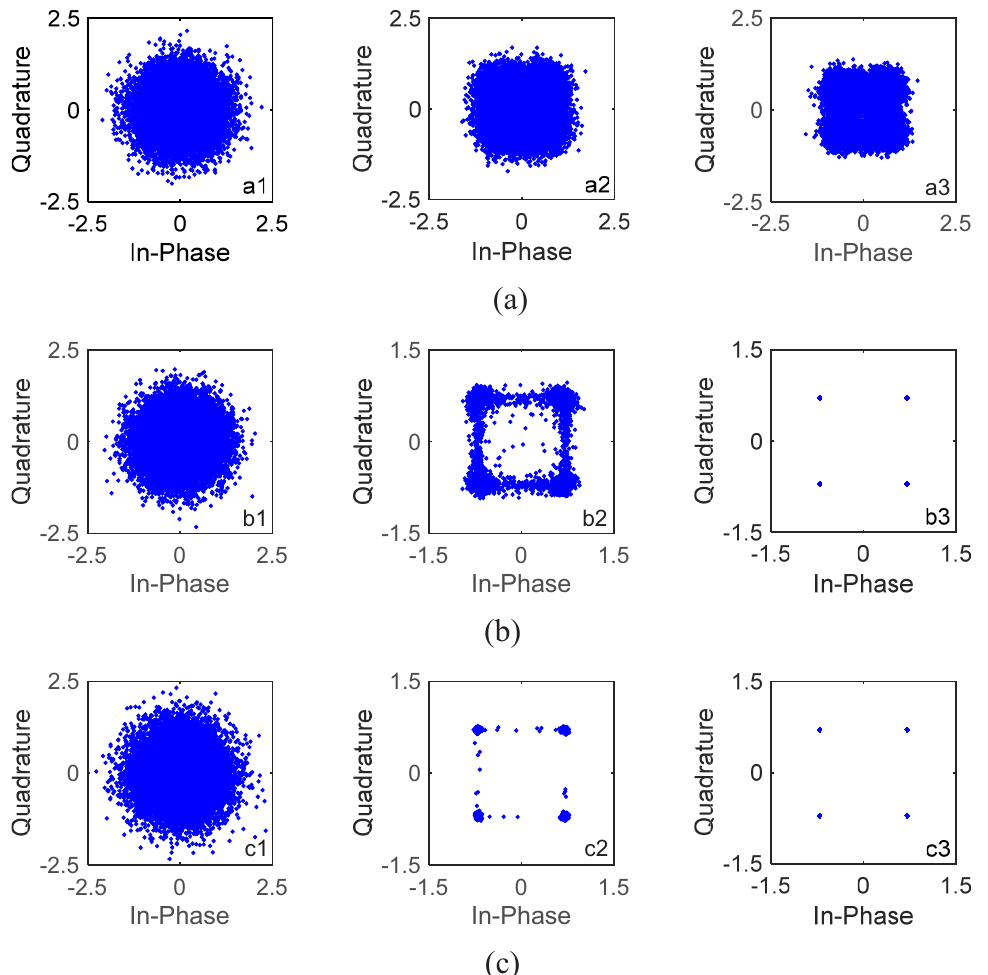
Figure 16. Constellations of the 16 blocks of data with S256 after 0, 1 and 2 iterations for Yellow Sea 1 in Figure 17. ( a1 ) Rate-1/4, 0 iteration; ( a2 ) rate-1/4, 1 iteration; ( a3 ) rate-1/4, 2 iterations; ( b1 ) rate-1/8, 0 iteration; ( b2 ) rate-1/8, 1 iteration; ( b3 ) rate-1/8, 2 iterations; ( c1 ) rate-1/16, 0 iteration;